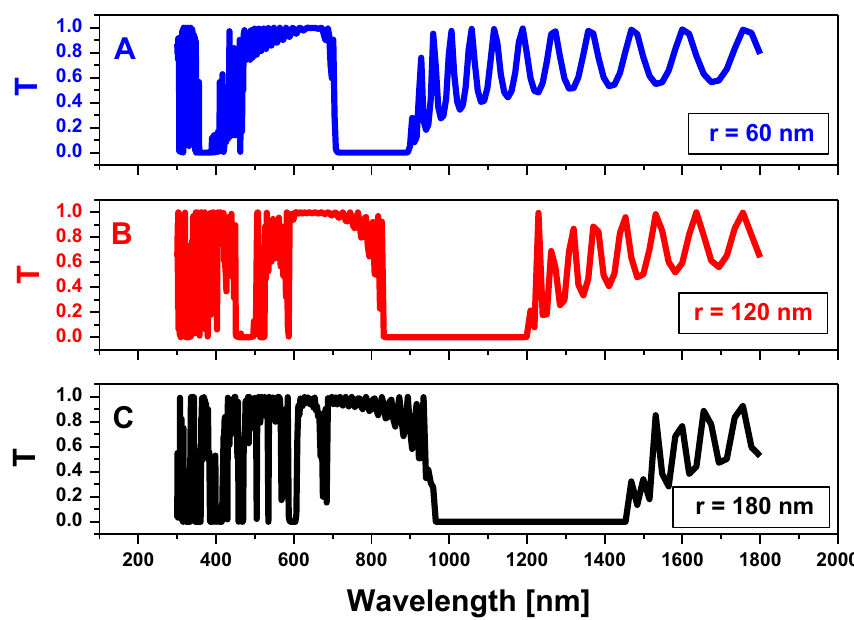
Figure 5. Transmission property of the two-dimensional hexagonal cylinder unit cell with D = 120nm , N = 11, and all cylinders are filled with air at host material from titanium dioxide ( TiO 2 ) at different values of r as